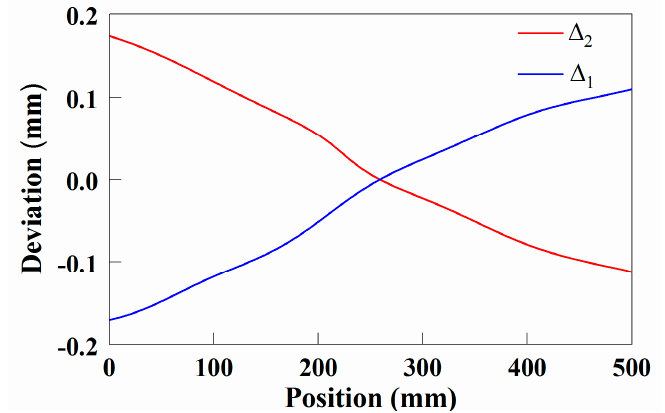
Figure 23. The average of the combined projection curves of the PA and PB surfaces.